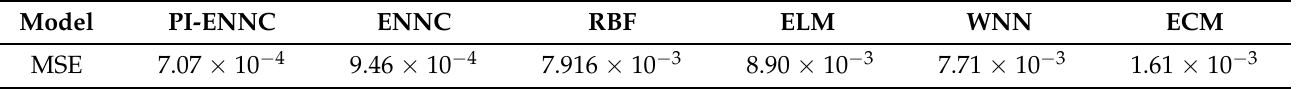
Table 6. Comparison of the PI-ENNC SoC MSE results with the models discussed in [46,68] on the NASA test set. Model